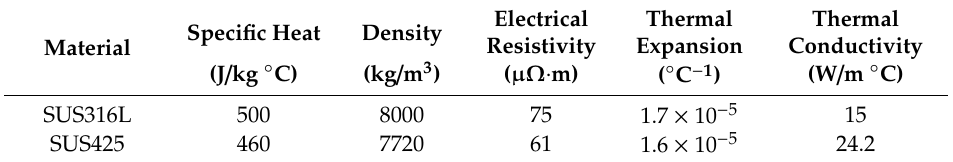
Table 3. Physical properties of base metals.